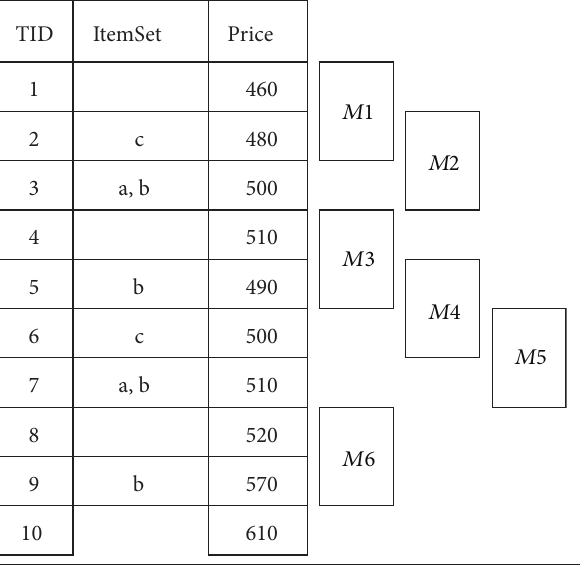
Table 1: An example of transactional database